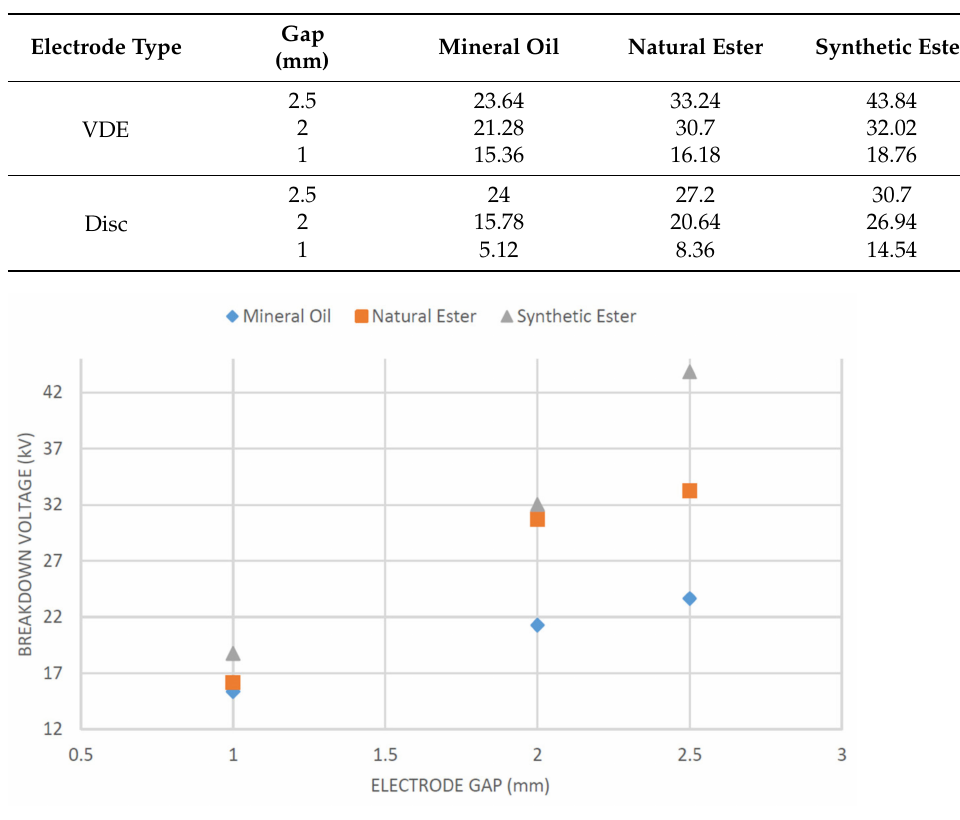
Figure 4. AC BDV—VDE type